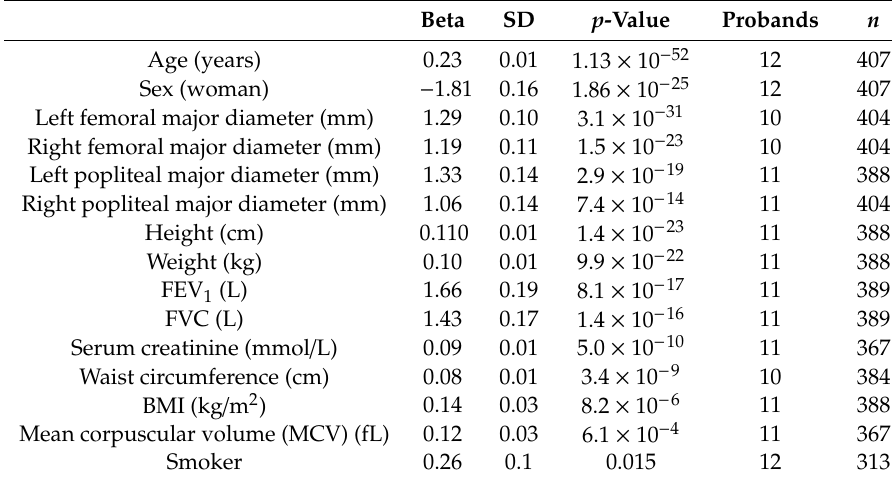
Table 3. Regression coe ffi cients for the main statistically significant covariates (FDR < 0.01). Except for age and sex, all variables were further adjusted by age, age 2 , and sex. Smoking status did not pass the FDR significance threshold, but it was further included for its known significance in aortic-related